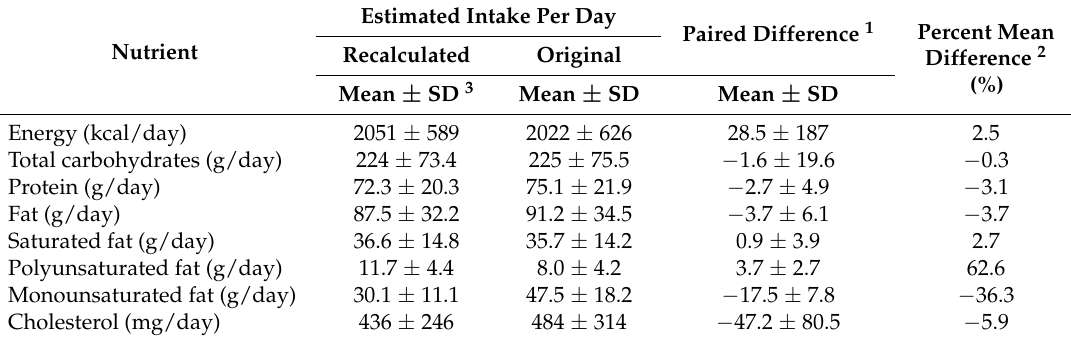
Table 2. Descriptive analyses for recalculated and original nutrient intake data ( n = 910).